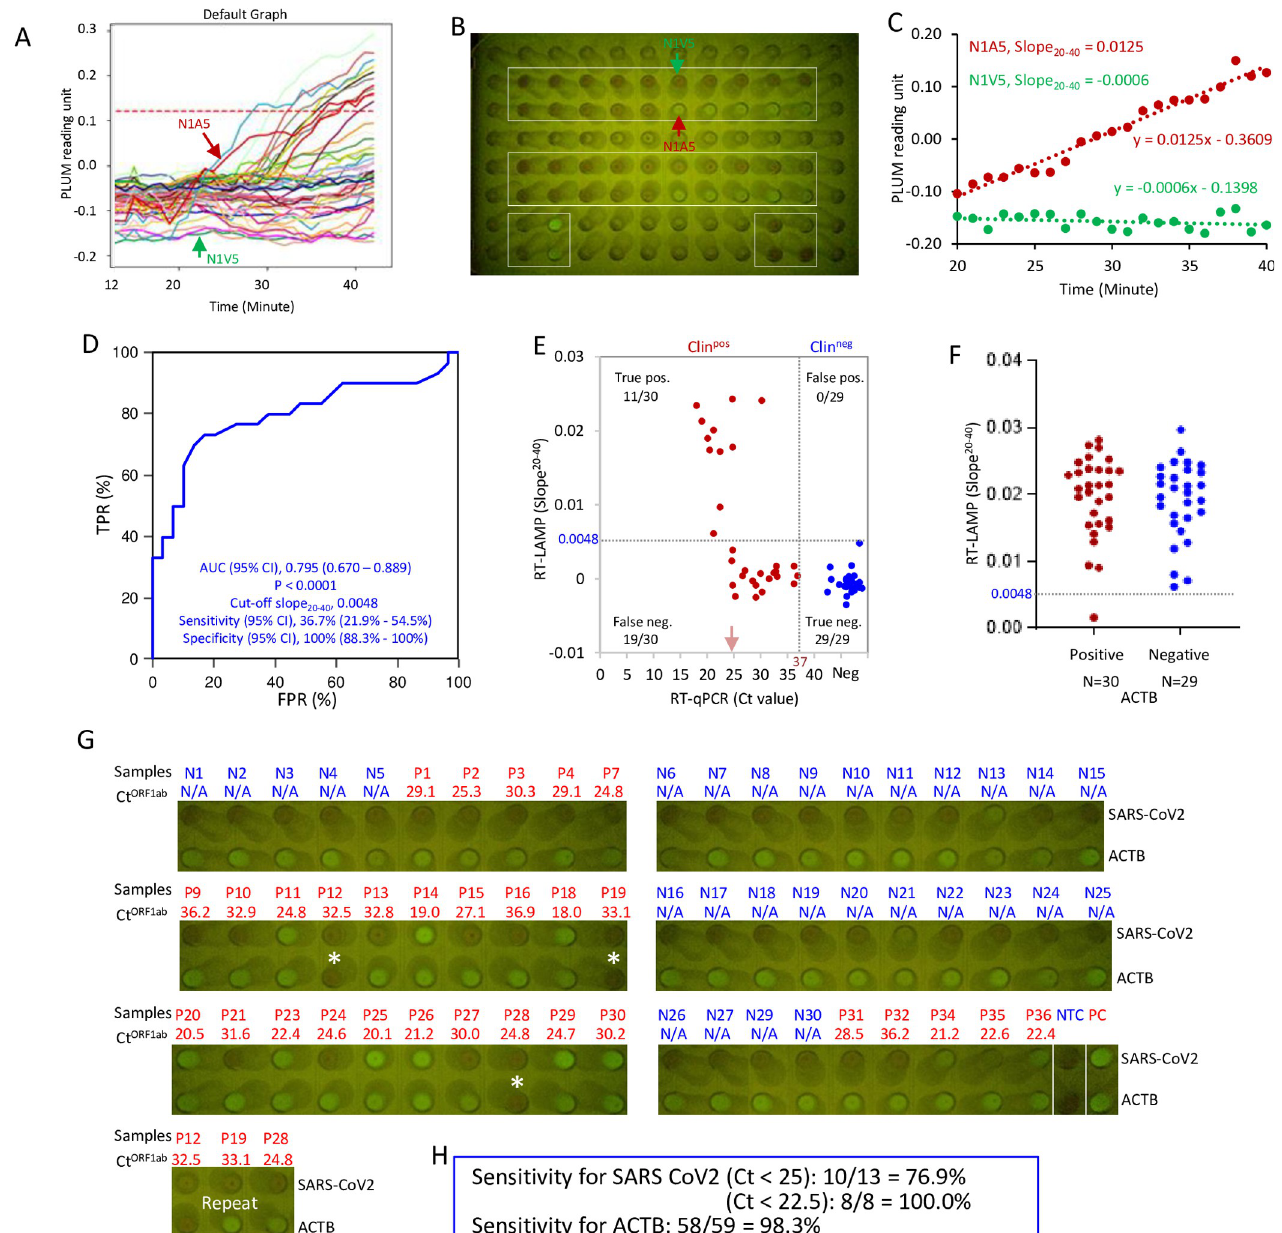
Fig 7. Direct RT-LAMP with FluoroPLUM. (A) FluoroPLUM readout of RT-LAMP assessment of the boxed wells in (B). Each solid line represents one reaction, monitored for 45 minutes, and quantified as ‘PLUM reading units’. N1A5 (red) and N1V5 (green) are examples of positive and negative samples, respectively. The red dash line is the average reading of all the wells in the plate (B) for the first 3 minutes. (B) Image of RT-LAMP reactions at the end of the experiment. (C) Slope 20-40 for the two reactions indicated in (A) and (B). (D) ROC curve evaluating FluoroPLUM performance using slope 20-40 values. (E) Distribution of slope 20-40 values vs . BGI RT-PCR Ct values. Dotted lines indicate cutoffs (RT-LAMP: Slope 20-40 > 0.0048 = positive, RT-PCR: Ct < 37 = positive). (F) Distribution of slope 20-40 for human ACTB in clinical NP samples. (G) Images of color changes for the 30 positive (red) and 29 negative (blue) clinical NP samples. Asterisks: Three samples with no amplification of ACTB, two of which showed amplification in a repeat run (bottom image). (H) Sensitivity with end-point data in (G).